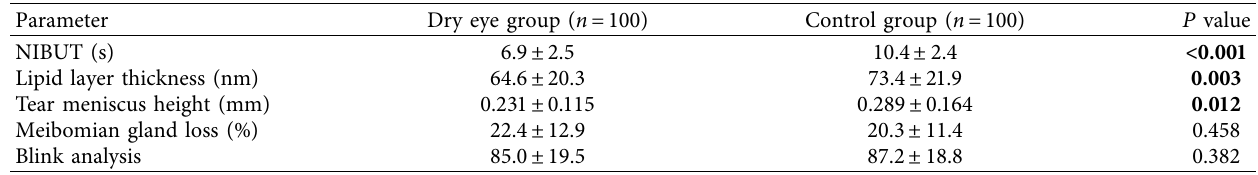
Figure 1: Ocular surface workup in a representative control subject (a, c, e, g, i) and in a patient with dry eye disease (b, d, f, h, j). (a, b) Measurement of noninvasive breakup time. (c, d) Tear film interferometry for the measurement of lipid layer thickness. (e, f) Measurement of tear meniscus height. (g, h) Infrared meibography. (i, j) Blink analysis. Table 1: Ocular surface parameters in patients with dry eye disease and control subjects.